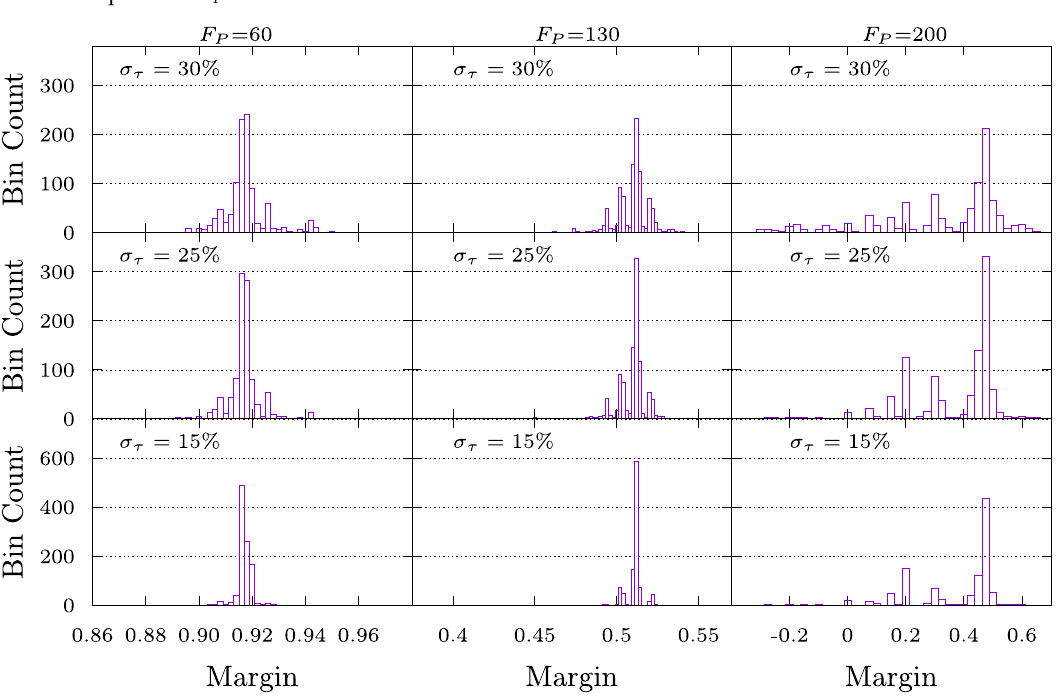
Figure 8. Histograms from Monte Carlo simulations (1000 runs each) showing the distribution of the Margin for σ τ = 30%, 25%,